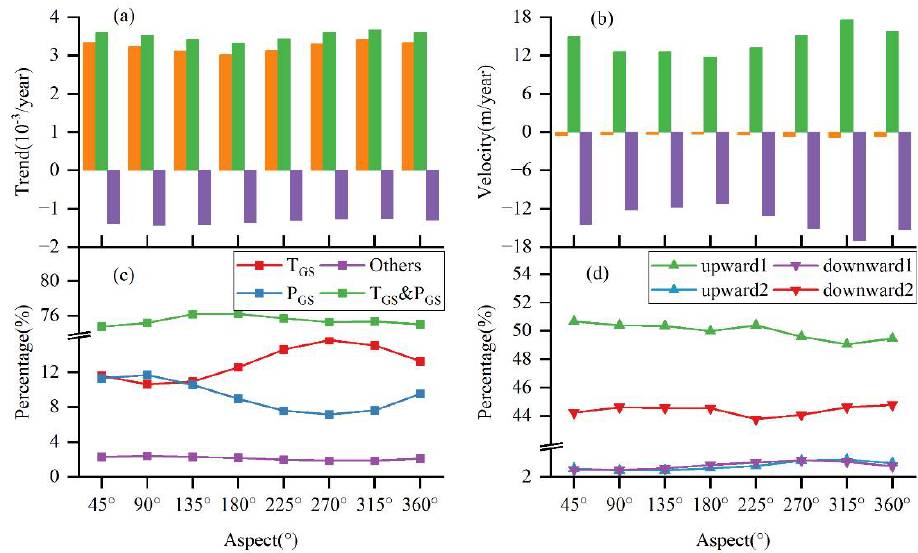
Figure 6. ( a ) Temporal rate of change in growing season NDVI (NDVI GS ) and ( b ) vertical velocity of vegetation greenness isolines for eight different aspect azimuth angles (the orange columns indicate the mean values for all pixels, the green columns the mean values for all positive pixels, and the purple columns the mean values for all negative pixels). ( c ) The percentage of pixels corresponding to each of the four driving-factor cases and ( d ) the percentage of pixels belonging to the different upward and downward categories for the eight different aspect azimuth angles.